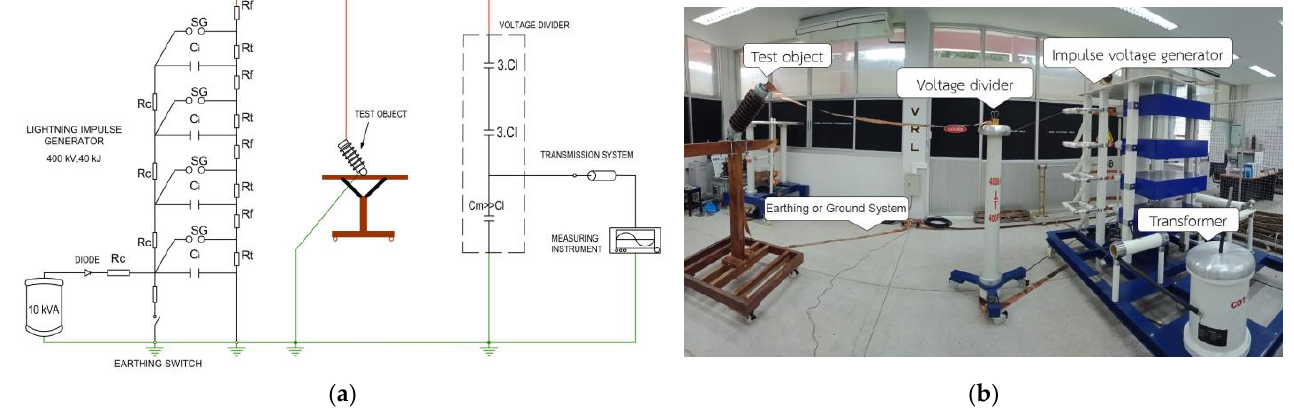
Figure 8. The experimental circuit of the lightning impulse critical-flashover voltage under normal condition test.( a ) The circuit diagram on the lightning impulse critical-flashover voltage test; ( b ) The test circuit set-up on the lightning impulse critical-flashover voltage test.